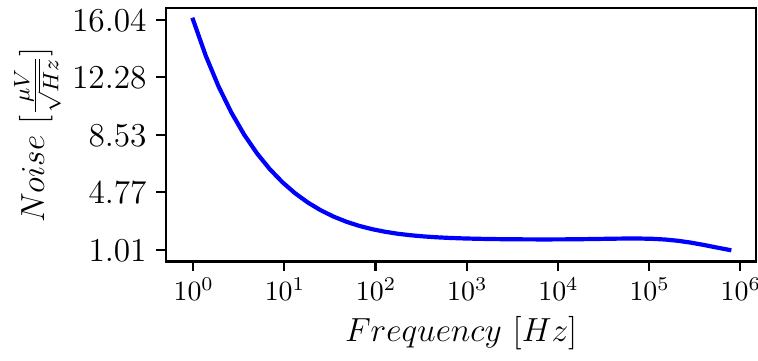
Figure 11. Input-referred spectral noise density.